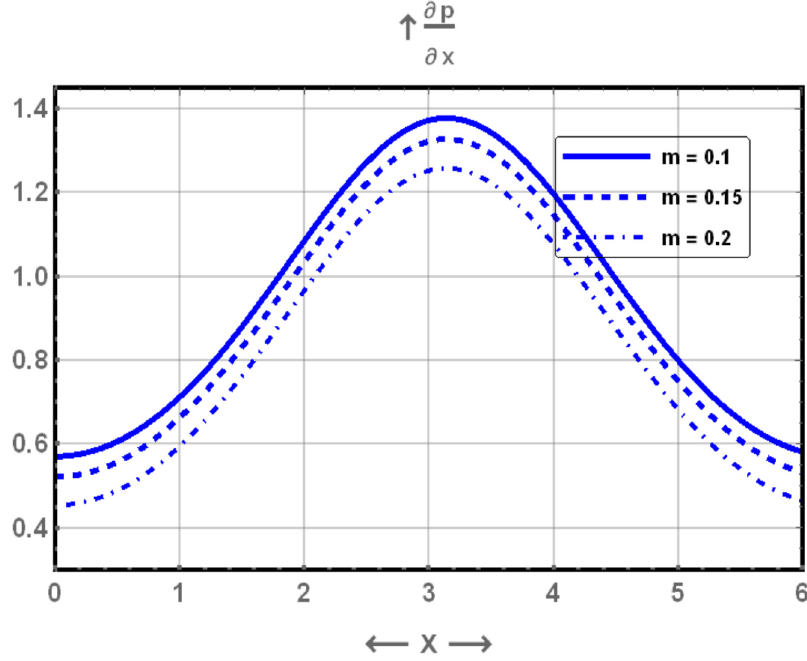
Figure 20. Display of pressure gradient for different values of Gr .